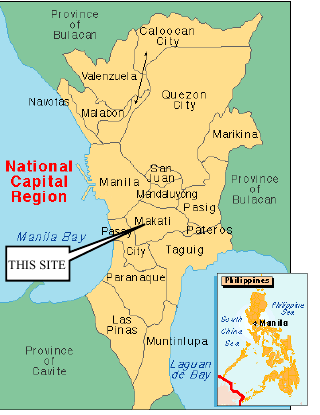
Figure 3 . Vicinity map of Makati City. Source: http://travelsfinders.com/manila-metro-map.html